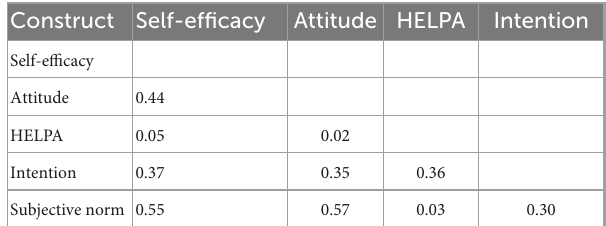
TABLE 4 The HTMT ratio with SmartPLS algorithm.